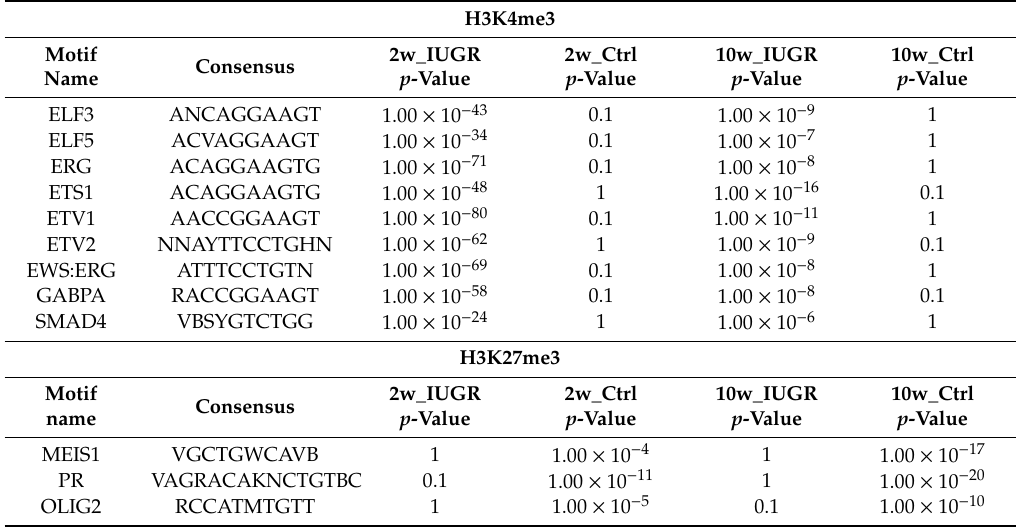
Table 5. Transcription factor binding motifs with persistent histone modification changes.